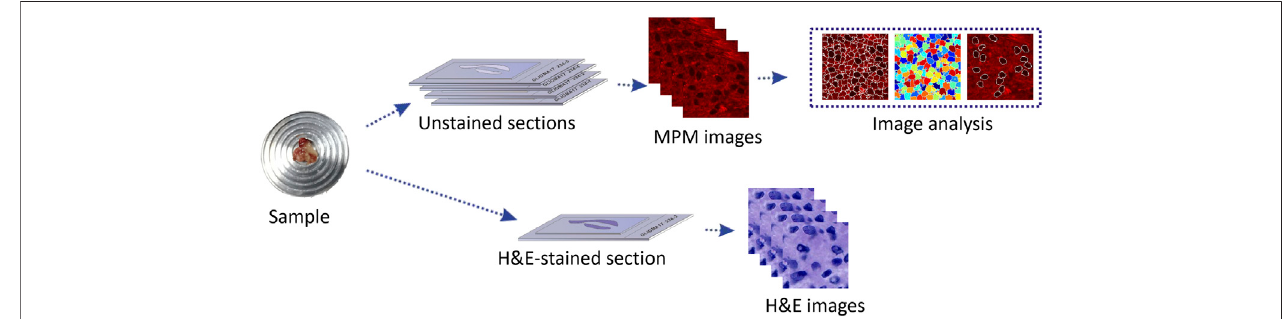
FIGURE 1 | Demonstration of preparation and analysis of the frozen sections in this study.